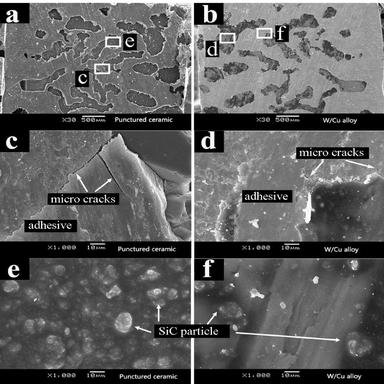
SEM images of the breakage surface of the punctured ceramic/W–Cu alloy bonding pairs (a) surface of the punctured ceramic; (b) surface of the alloy (c) and (e) magnified images of the light area and dark area in Fig. 7(a), (d), and (f) magnified images of the light area and dark area in Fig. 7(b), respectively.